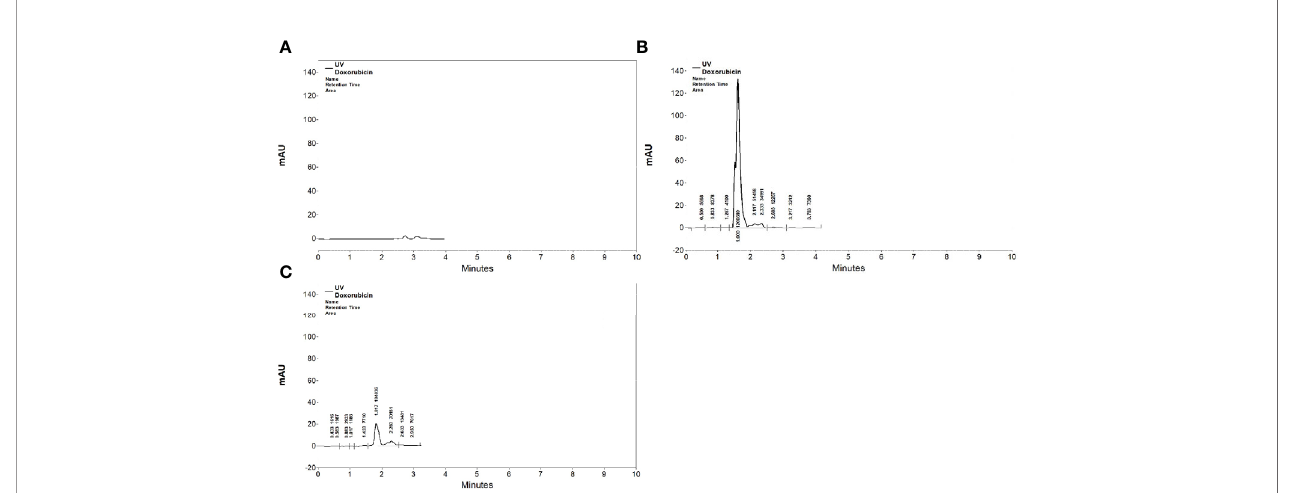
FIGURE 4 | Doxorubicin detection in exosome samples by high-performance liquid chromatography (HPLC). (A) Absorption spectrum of digested exosomes extracted from untreated U937 cells, (B) Absorption spectrum of 10 ppm doxorubicin standard sample, (C) Absorption spectrum of digested exosomes extracted from U937 cells treated with 2 m M PLD. The presence of doxorubicin in the exosomes and thus the ability of the exosomes to package and export the drug is indicated based on the absorption spectrum of the injected digested exosome